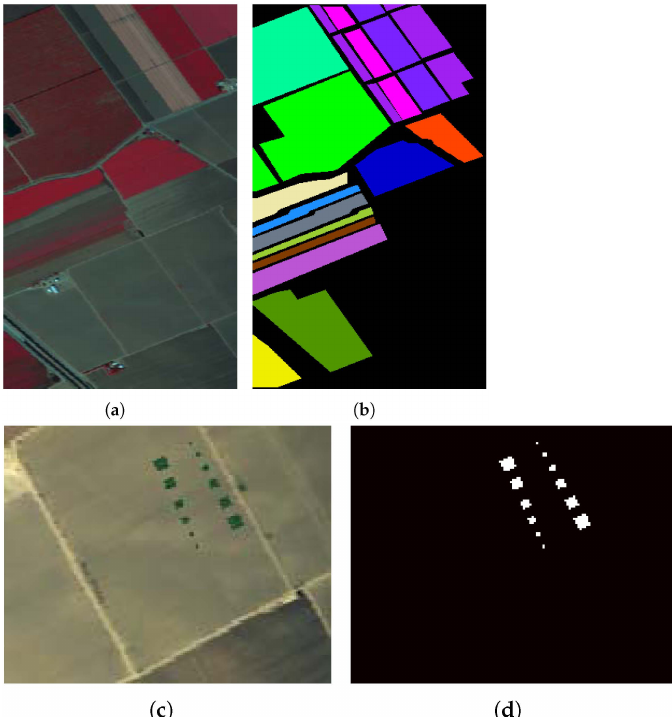
Figure 5. Image scene descriptions. ( a ) False color image of the Salinas dataset. ( b ) The ground truth map of the Salinas dataset. ( c ) False color image of the Salinas-simulate dataset. ( d ) The ground truth map of the Salinas-simulate